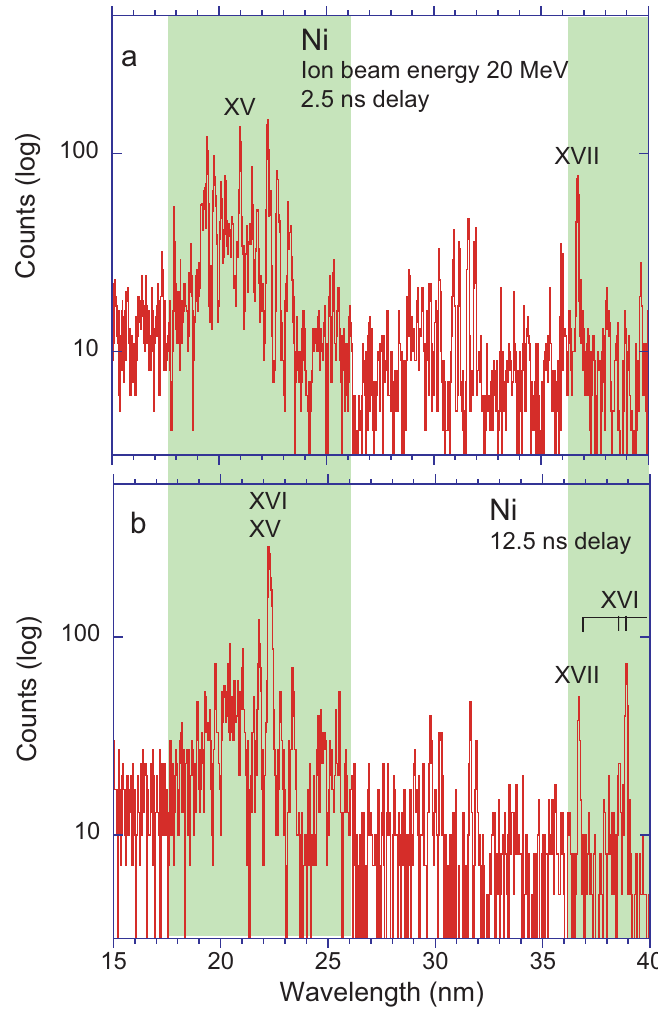
Figure 20. Beam–foil spectra of Ni at an ion beam energy of 20 MeV. ( a ) Observation at a delay of about 2.5 ns after excitation, line width (FWHM) 0.09 nm; ( b ) observation at a delay of about 12.5 ns after excitation, line width (FWHM) 0.11 nm. The strongest lines are identified by the spectrum number. Unidentified lines are marked by a fiducial with a question mark. The charge state distribution is centered on q = 13 + , and ion charge states q = 10 + to q = 17 + are expected to contribute. The green bands mark ranges of evident emission by long-lived